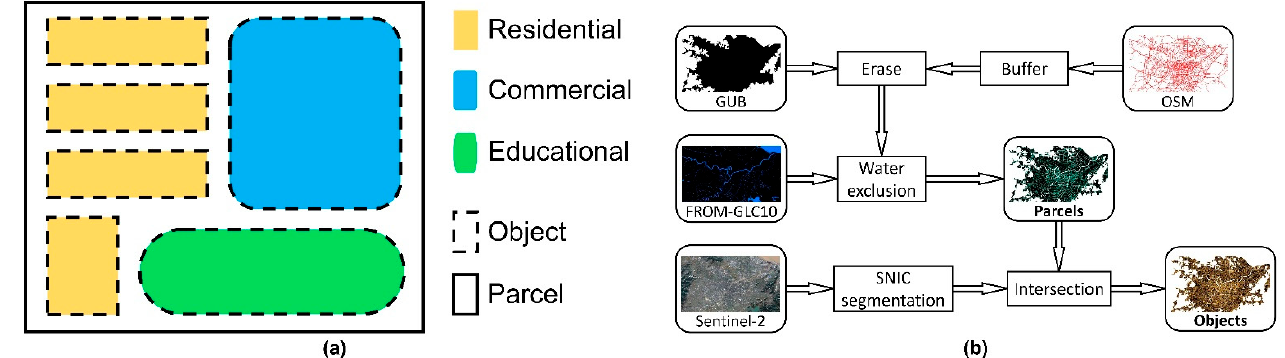
Figure 1. Relationship between parcels and objects. ( a ) An illustration of the spatial correlation between parcels and objects. A parcel can include several objects with different land uses, such as residential areas, commercial areas, and educational areas. ( b ) Processes for generating mapping units of parcels and objects. OSM: OpenStreetMap road network. GUB: global urban boundaries. FROM-GLC10: the 10 m global land cover product. SNIC: simple non-iterative clustering.